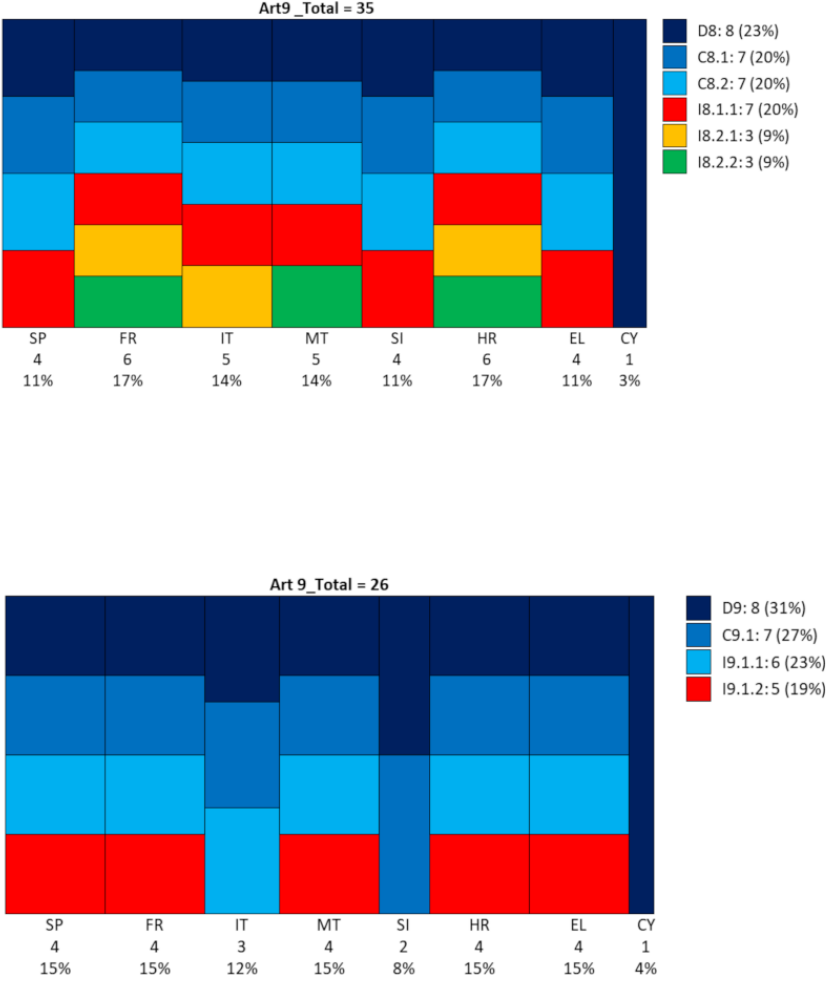
Figure 6. Application of Com Dec 2010/477/EU criteria (C) and indicators (I) in Art 9 for contami- nants descriptors by Mediterranean MS in